Question: Summarize what this figure shows in one sentence.
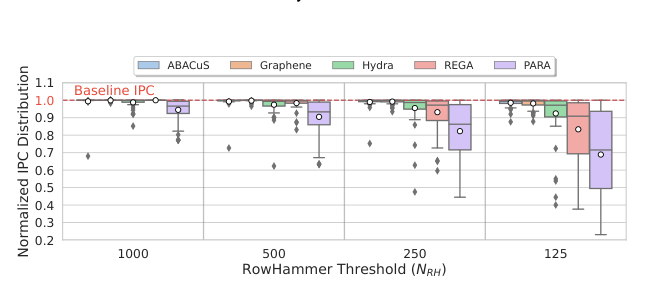
Answer: Performance comparison of ABACuS vs. state-of- the-art mitigation techniques for single-core workloads at four different RowHammer thresholds.